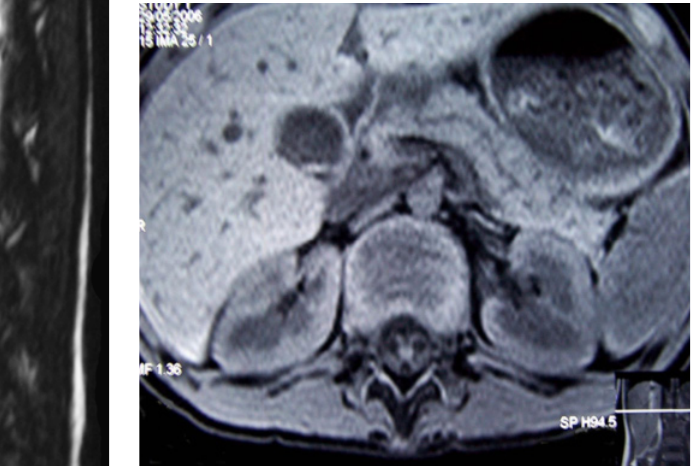
Figure 3. Magnetic resonance showing resolution of pancreatic pseudocyst on the 38th day of octreotide